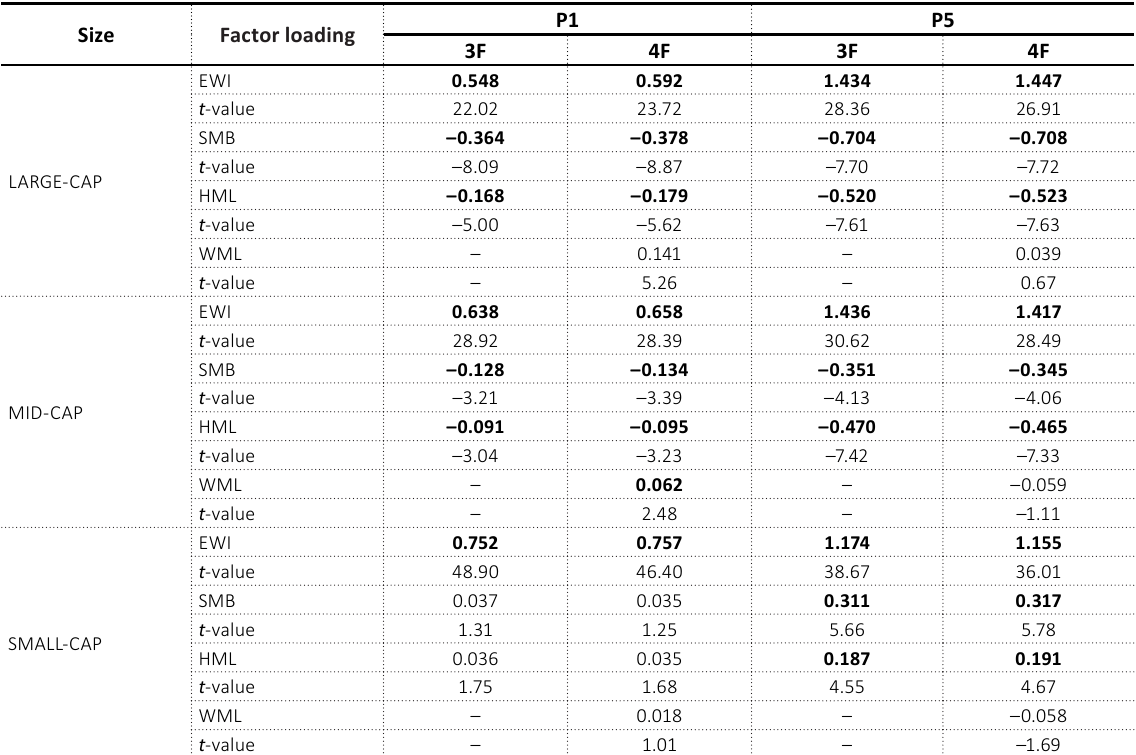
Table 17. Th ree-factor and four-factor regression coefficients of volatility ranked portfolios of large- cap, mid-cap and small-cap